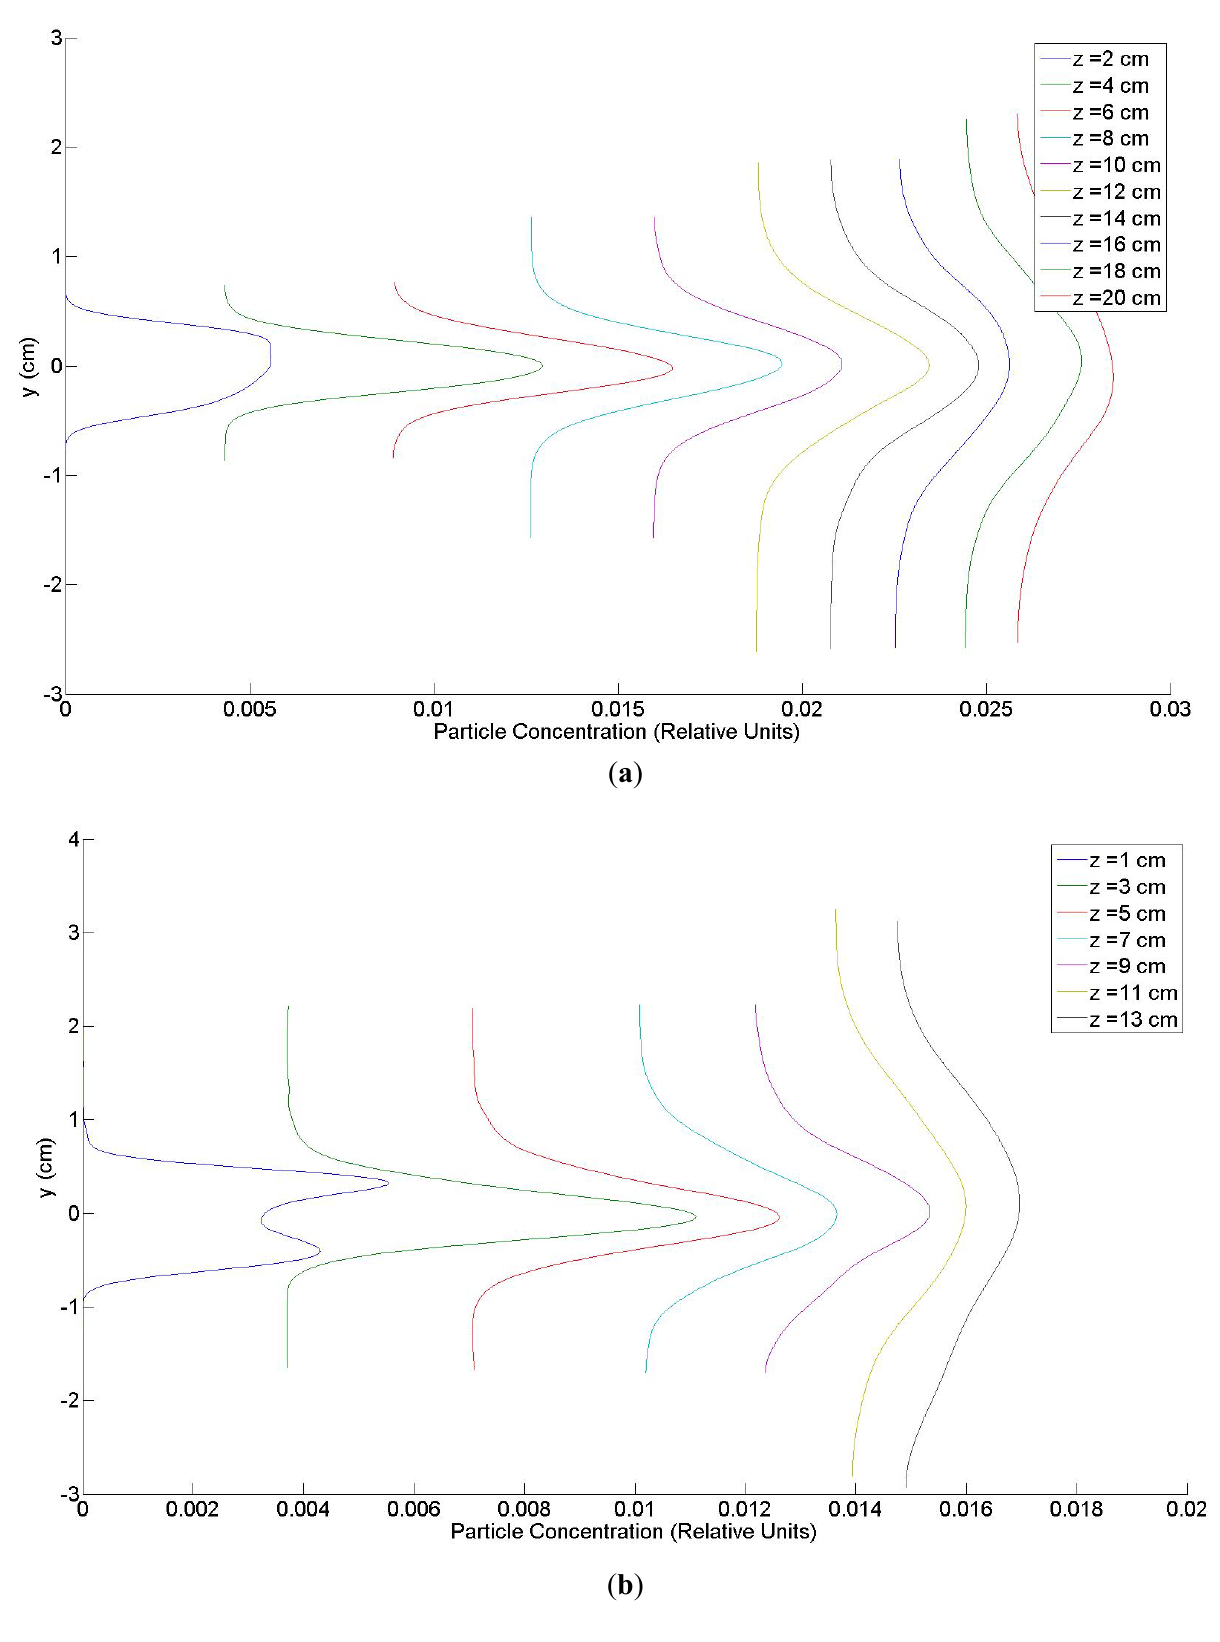
Figure 8. The particle distribution from longitudinal section images for ( a ) Gun Head 2: Experiment 2 and ( b ) Gun Head